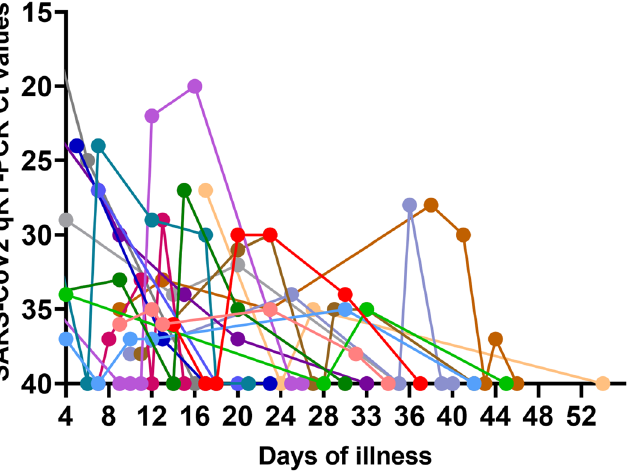
Figure 1. Patterns of SARS-CoV-2 viral shedding in respiratory samples in patients with prolonged COVID-19 illness. Realtime qPCR was carried out in individuals with prolonged shedding (n = 17) throughout the course of illness to determine the patterns and duration of virus